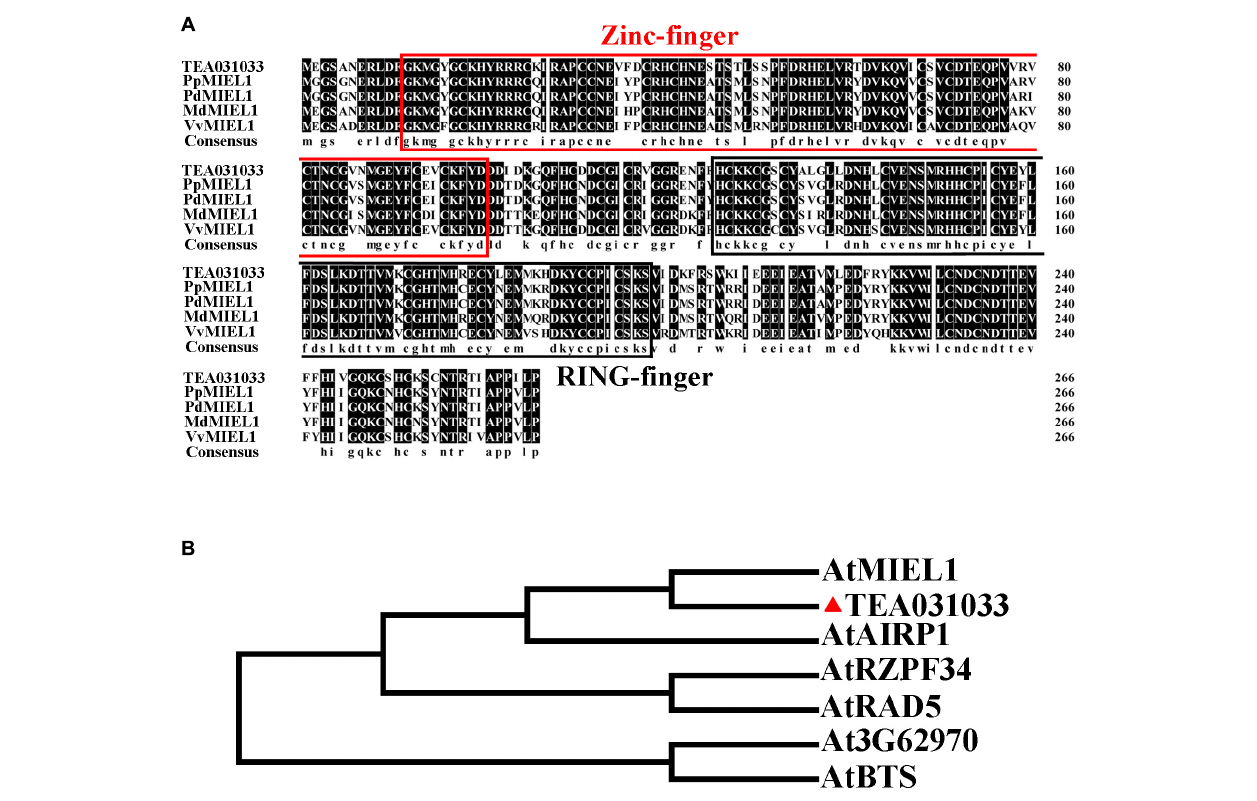
FIGURE 4 | Bioinformatics analysis of CsMIEL1. (A) Amino acid sequence alignment of MIEL1 in different species. (B) Phylogenetic analysis of TEA031033 and RING-containing proteins in Arabidopsis .